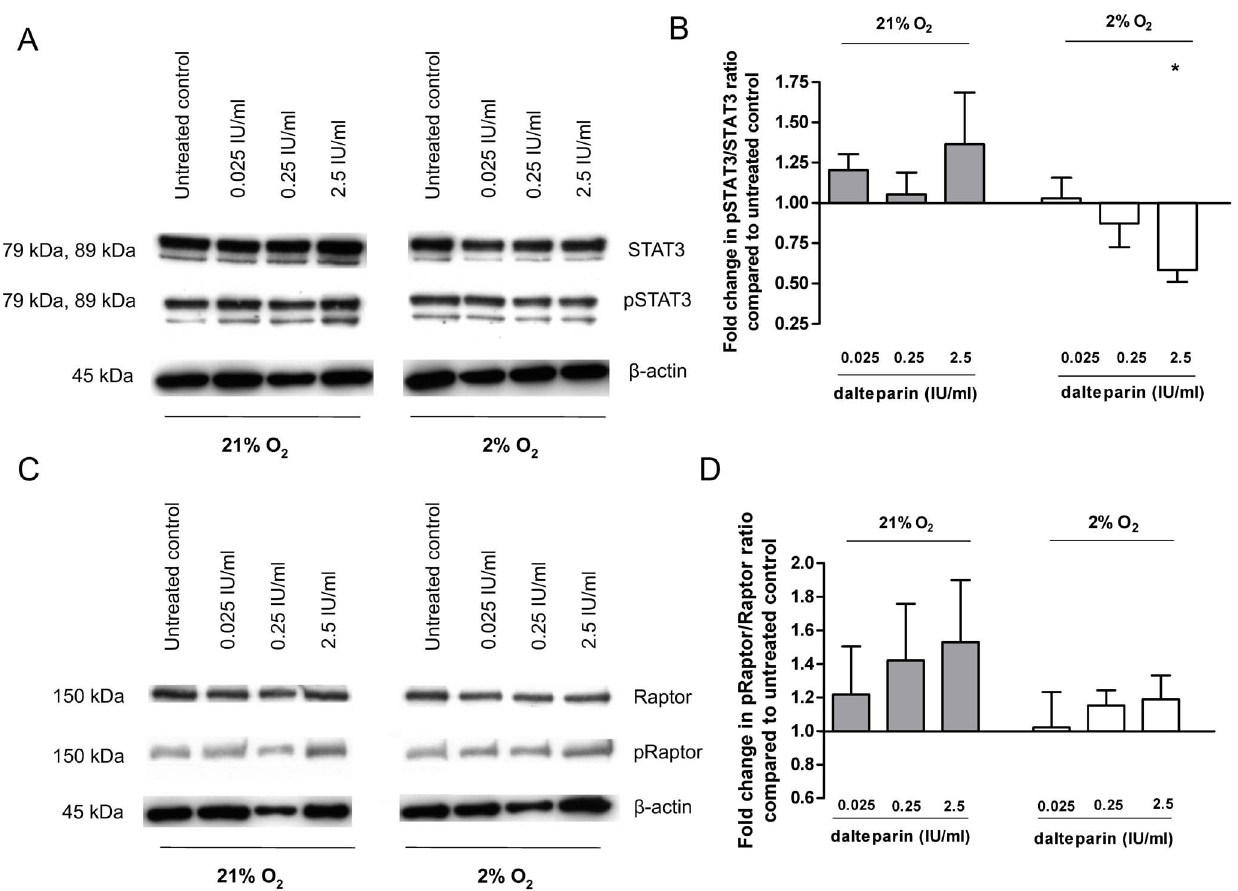
Figure 3. Protein expression of pSTAT3/STAT3 (A, B) and pRaptor/Raptor (C, D) in placental villous explants after incubation with dalteparin (0.025 IU/ml, 0.25 IU/ml, 2.5 IU/ml) at 21% and 2% O 2 . Representative Western blot of STAT3, pSTAT3 and b -actin (A) or Raptor, pRaptor and b -actin (C). Representative bar graph showing pSTAT3/STAT3 (B) and pRaptor/Raptor (D) ratios for dalteparin treated villous fragments compared to control. Data are presented as relative means 6 SEM. *p , 0.05 compared to untreated control (set to 1).